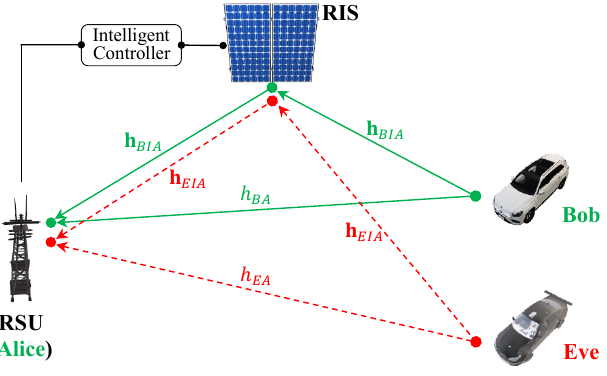
Figure 3. RIS-assisted channel